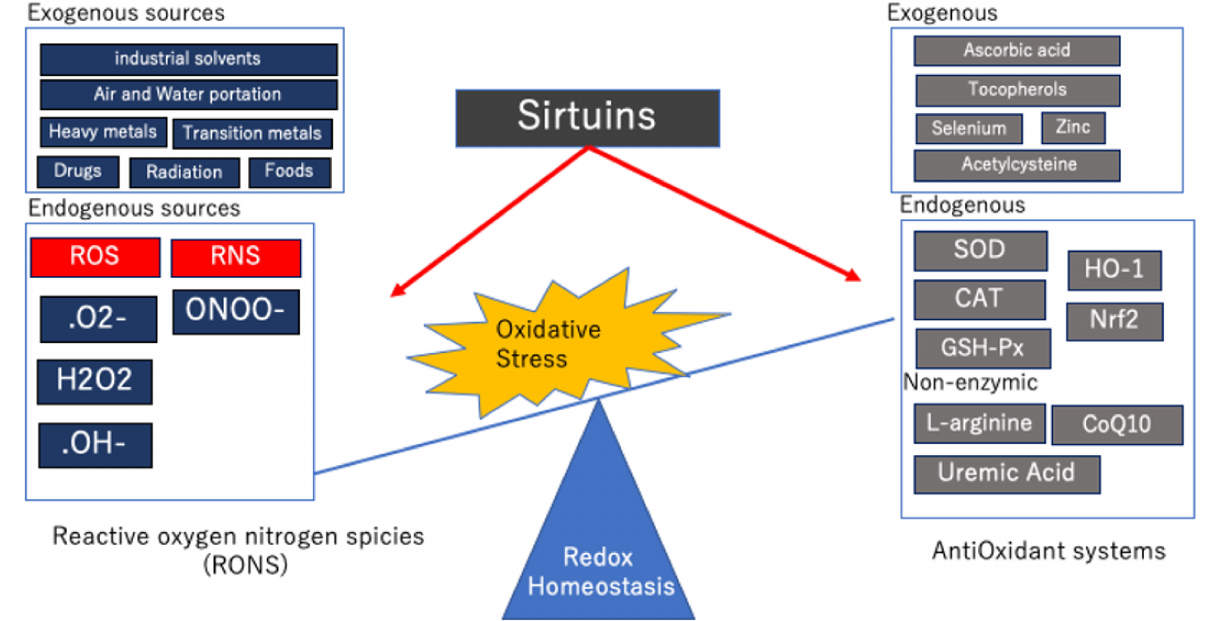
Figure 1. The imbalance between free radicals and antioxidant systems induces cell injury with consequent renal failure pathogenesis. Sirtuins are involved in processes and functions related to antioxidant and oxidative stress. Abbreviations: Reactive oxygen species: ROS, Reactive nitrogen species: RNS, Hydrogen peroxide: H 2 O 2 , Superoxide anion radicals: O 2 •− , Nitric oxide: NO, Nicotinamide adenine dinucleotide phosphate oxidase: NOX, Peroxynitrite: ONOO − , Super